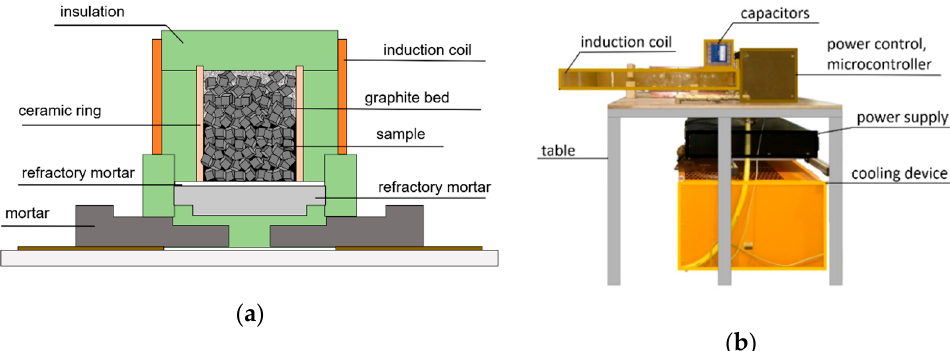
Figure 2. ( a ) Schematic illustration of the crucible concept used in the InduMelt experiments [29] and ( b ) setup of the experimental InduMelt plant.